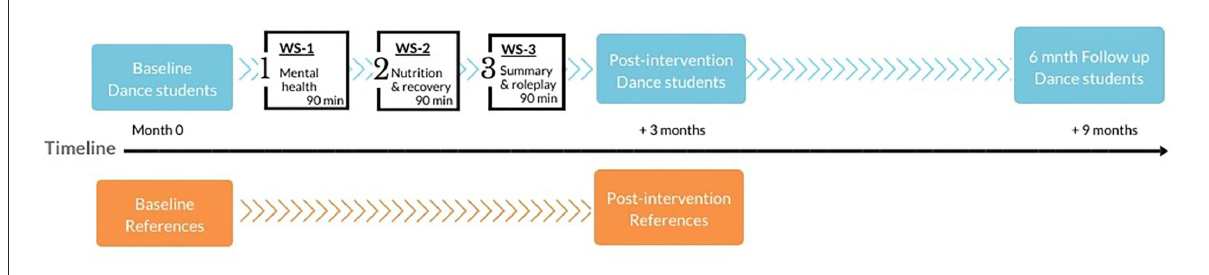
FIGURE1 A diagram illustrating the flow of interventions and evaluations. Blue/dark and orange/light boxes illustrate the time for evaluations of dance students and references, respectively, and white boxes illustrate workshop interventions for dance students and their main focus. WS,